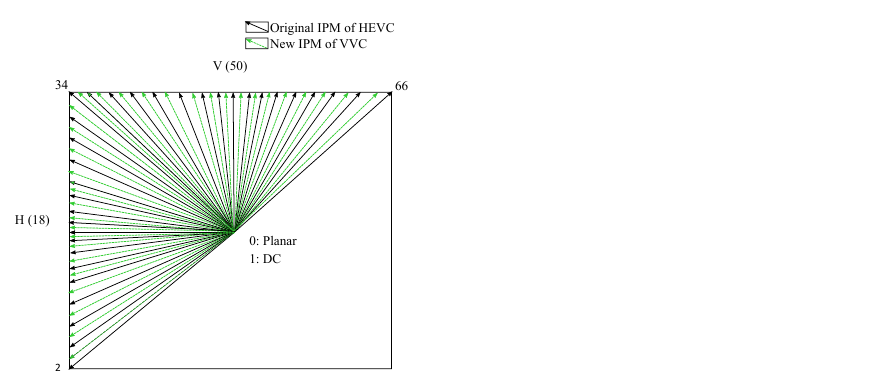
Figure 1. Illustration of the 67 IPMs. V and H are vertical and horizontal modes, respectively.